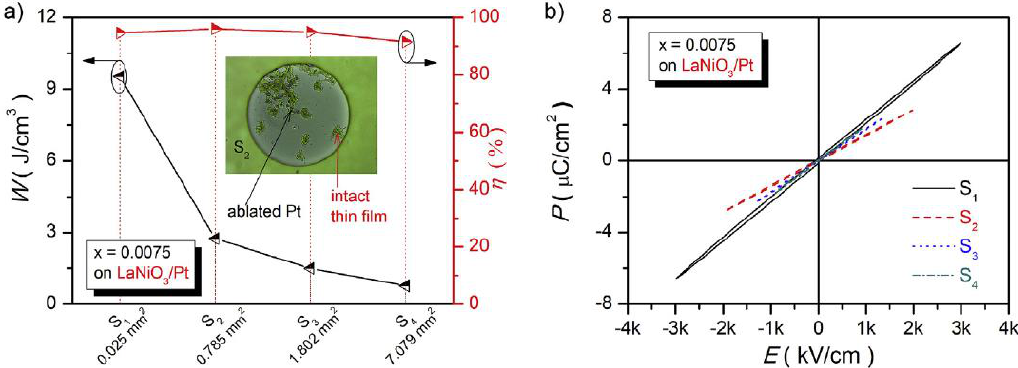
Figure 17. La-doped BCZT thin films at x = 0.0075 on LaNiO 3 / Pt composite bottom electrodes. The area of top electrode as a function of W and η . Inset: image of Pt top electrode ( a ). Polarization-electric field (P-E) loops with various sizes of Pt top electrodes ( b ). Reprinted with permission from [62]. Copyright 2019 Elsevier. Table 2. Comparison of dielectric and energy storage properties of BCZT thin films.